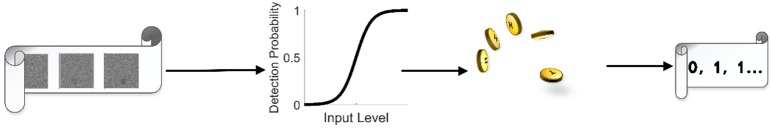
Instantaneous model observers were simulated to separate effects of the input structure from internal biases.Instantaneous model observers receive a stream of input signals (xi; left) which goes through a local sigmoid input-output relation f(xi) to define a probability of detection for each input (middle). The response is then determined by a coin-toss according to this probability resulting in a binary detection (right).